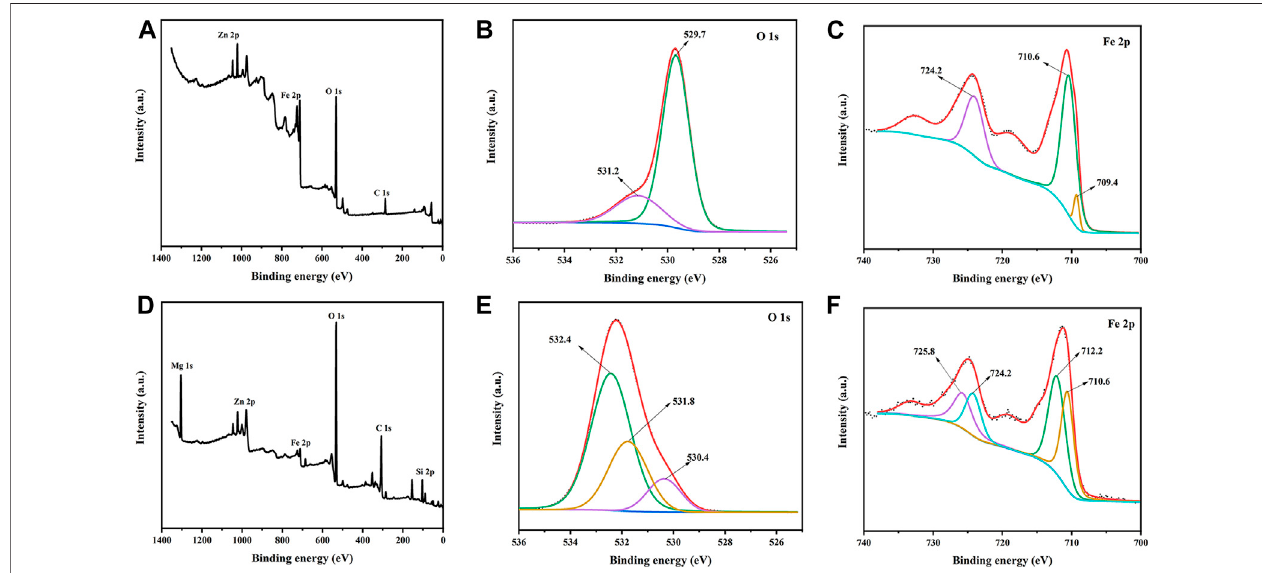
FIGURE 5 | XPS spectra of ZnFe 2 O 4 (A) survey (B) O 1s spectrum (C) Fe 2p spectrum; and ZF-Sep-11 (D) survey (E) O 1s spectrum (F) Fe 2p spectrum.